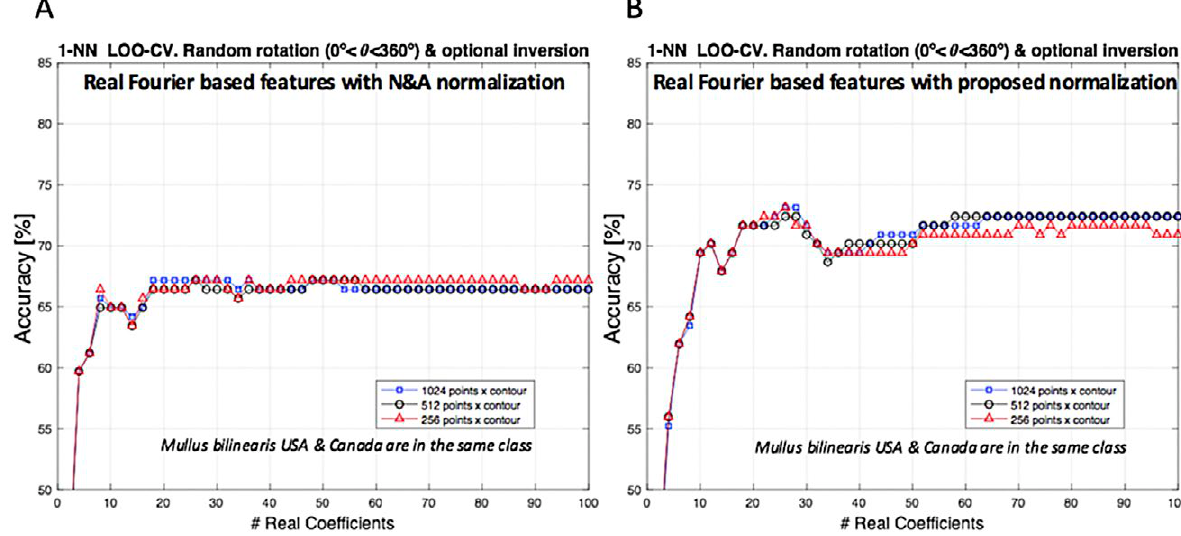
Fig. 7. – k -NN ( k =1) classification results with LOOCV for # real coefficients employed. All incoming contours are randomly rotated (0°-360°) and may or may not appear inverted. In A, the Nixon and Aguado normalization is employed and, in B, it is used for its own